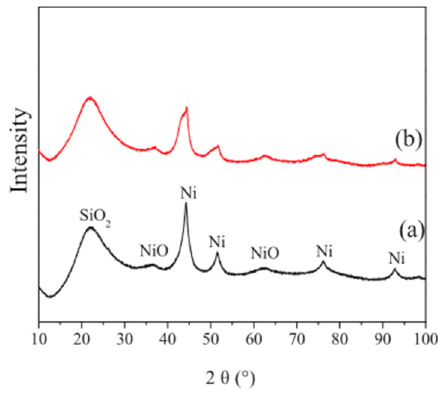
Figure 2. XRD pattern of Ni/SiO 2 catalyst sample. ( a ) Fresh catalyst. ( b ) Spent catalyst after 5 h test. Reproduced with permission from [59], Copyright 2015, Elsevier.